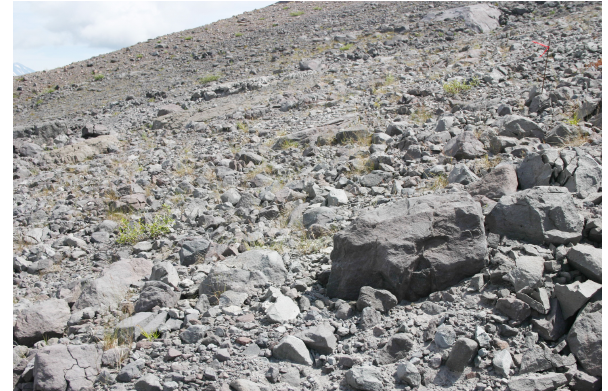
Fig. 6. Lower lahar on the south side of Mount St. Helens, adja- cent to woodland, with strong invasion by Abies and Pinus evident (Photo: RdM 2008).